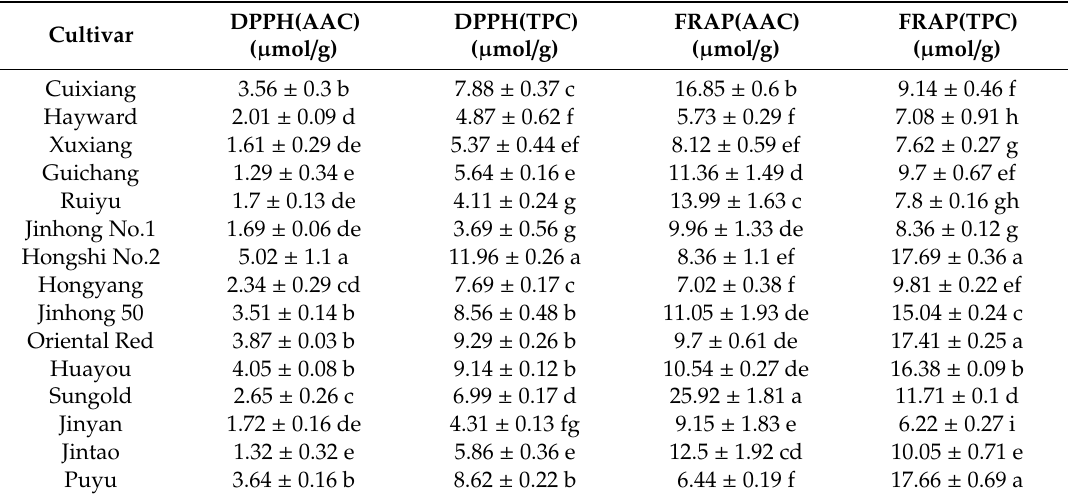
Table 3. Antioxidant activities of 15 kiwifruit cultivars measured by DPPH and FRAP assays. Cultivar